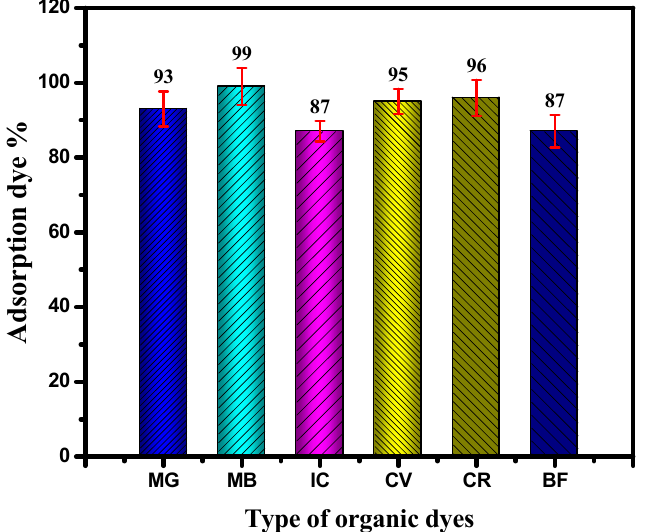
Figure 10. Applicability of MgTiO 3 @g-C 3 N 4 for removing other organic contaminants from water.